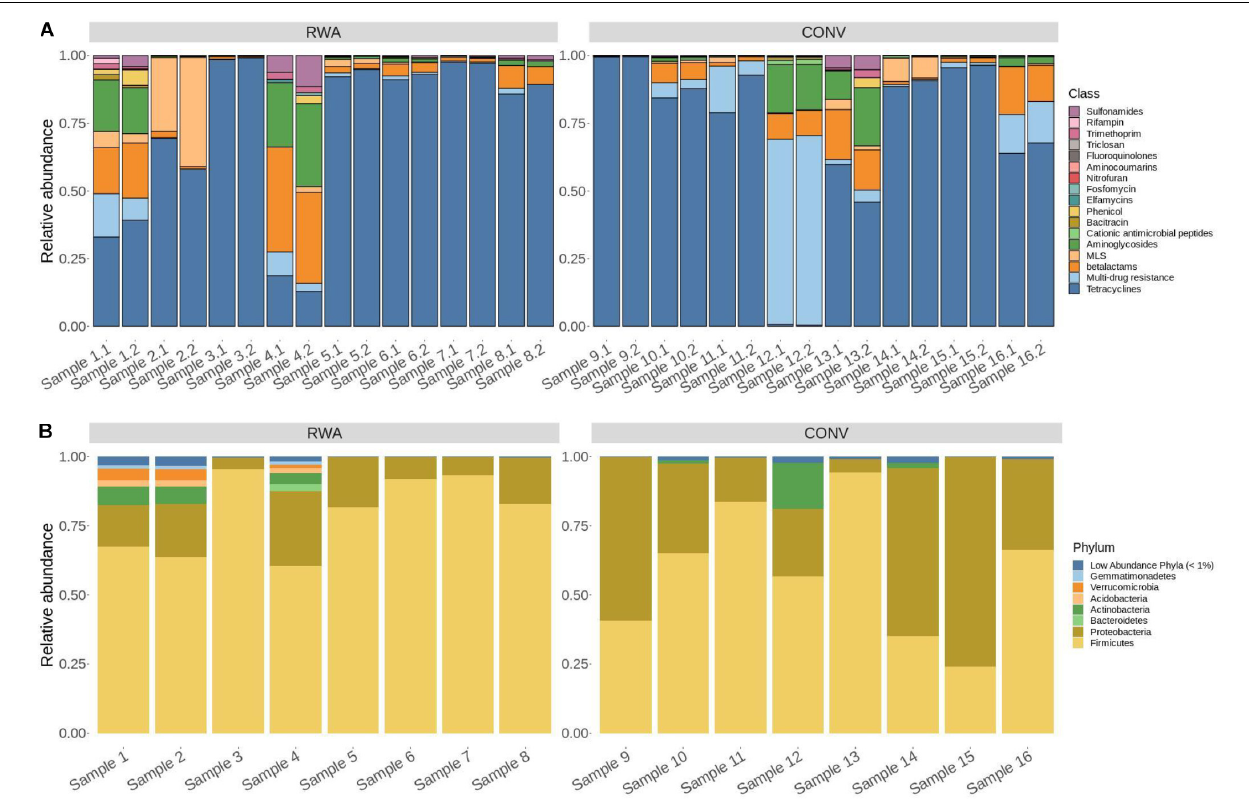
FIGURE 1 | Stacked bar graphs showing the (A) resistome composition and (B) microbiome composition of ground beef samples in this study. Individual ground beef samples are on the x -axis and relative abundance proportions are on the y -axis. (A) Resistome composition at the AMR drug class level for all 16 CONV and RWA ground beef samples in the study, including biological replicates ( N = 32). (B) Microbiome composition at the phylum level for all 16 ground beef samples, with phyla composing less than 1% of all microbiome counts labeled as “Low Abundance Phyla.”